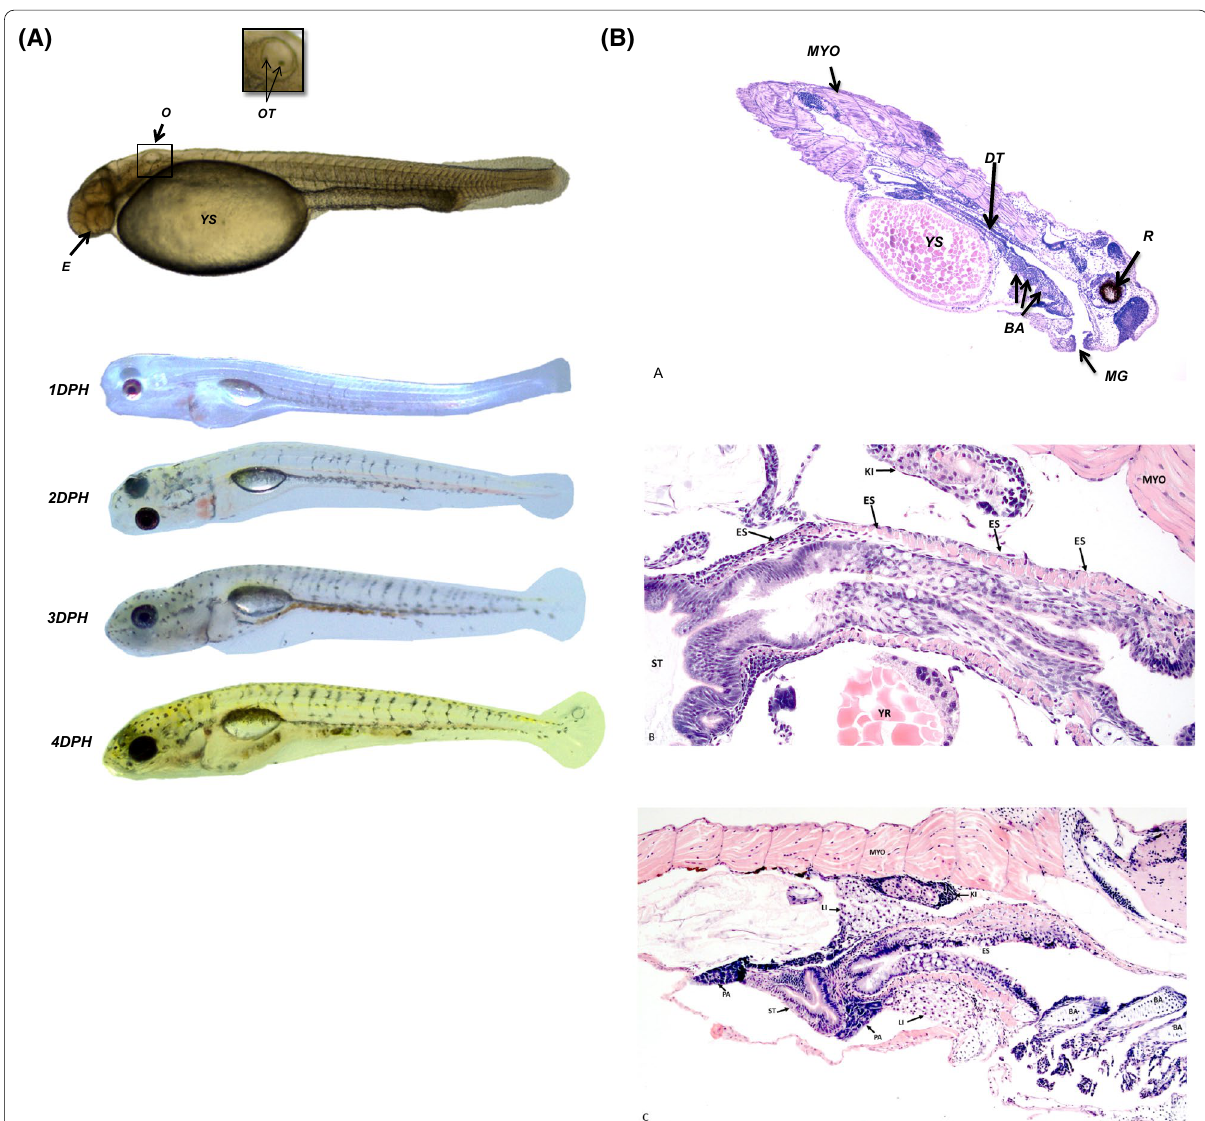
Fig. 8 A Prochilodus magdalenae hatching period and early larval development. Morphological development of larvae from 1 day post‑hatch (DPH) to 4 DPH. Abbreviations: E: eye; O: otic cup; YS: yolk sac; OT: otolith. B Prochilodus magdalenae . (A) Endogenous feeding period: The yolk sac is seen; the digestive tract is a straight tube; retinal pigmentation starts; retina become multilayer structure; gill anlage visible; mouth gap increases and the mouth arrives at the subterminal position; and jaw structures are well defined, H&E 4X. (B) Endo–exogenous feeding period: remains of yolk sac are present; esophagus, stomach and kidney are evident, H&E 20X. (C) Exogenous feeding period: The yolk sac fully depletes; myotomes are W‑shape. Esophagus, stomach, liver, pancreas and kidney are evident H&E 10X. Abbreviations: BA: branchial arches; GF: gill filaments; ES: esophagus; E: eye;